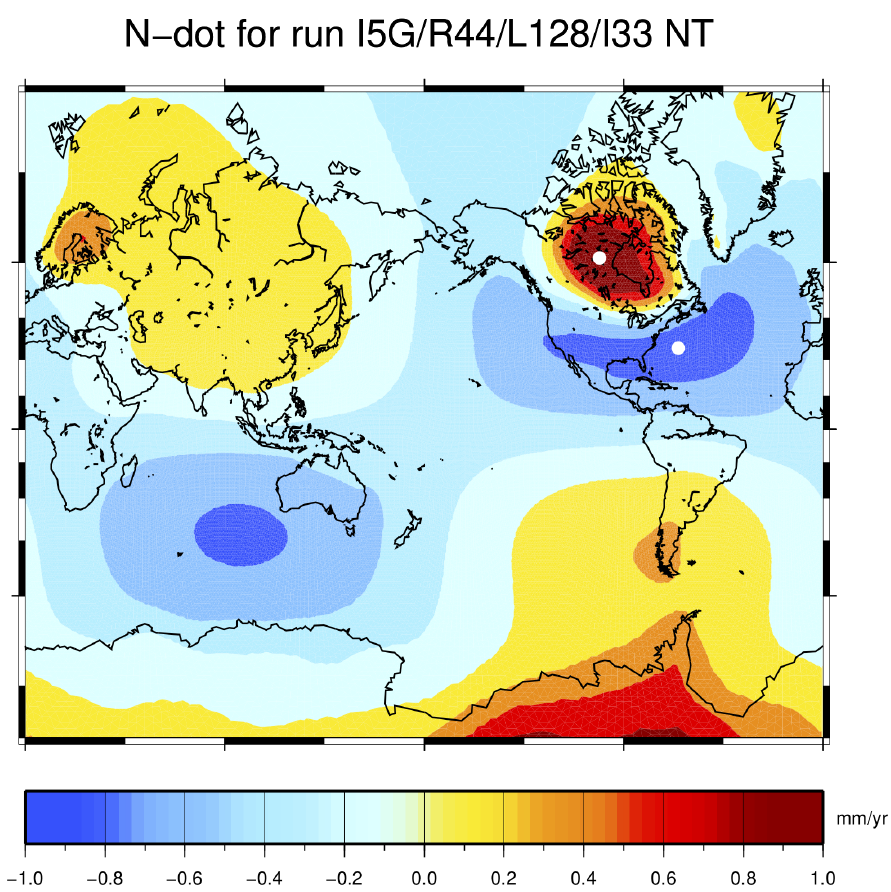
Figure 6. Fingerprint for ˙ , which represents the current rate of sea surface variation or absolute N sea-level change according to our implementation of GIA model ICE-5G (VM2). White dots mark the + 1.4 mm year − 1 , respectively. places where the largest rates are expected, with ˙ 0.9 and ˙ N ∼ − N ∼ The spatial variability of ˙ matches that of ˙ in Figure 5, since the two fingerprints only differ by the N G spatially invariant term ˙ c , where c is the FC76